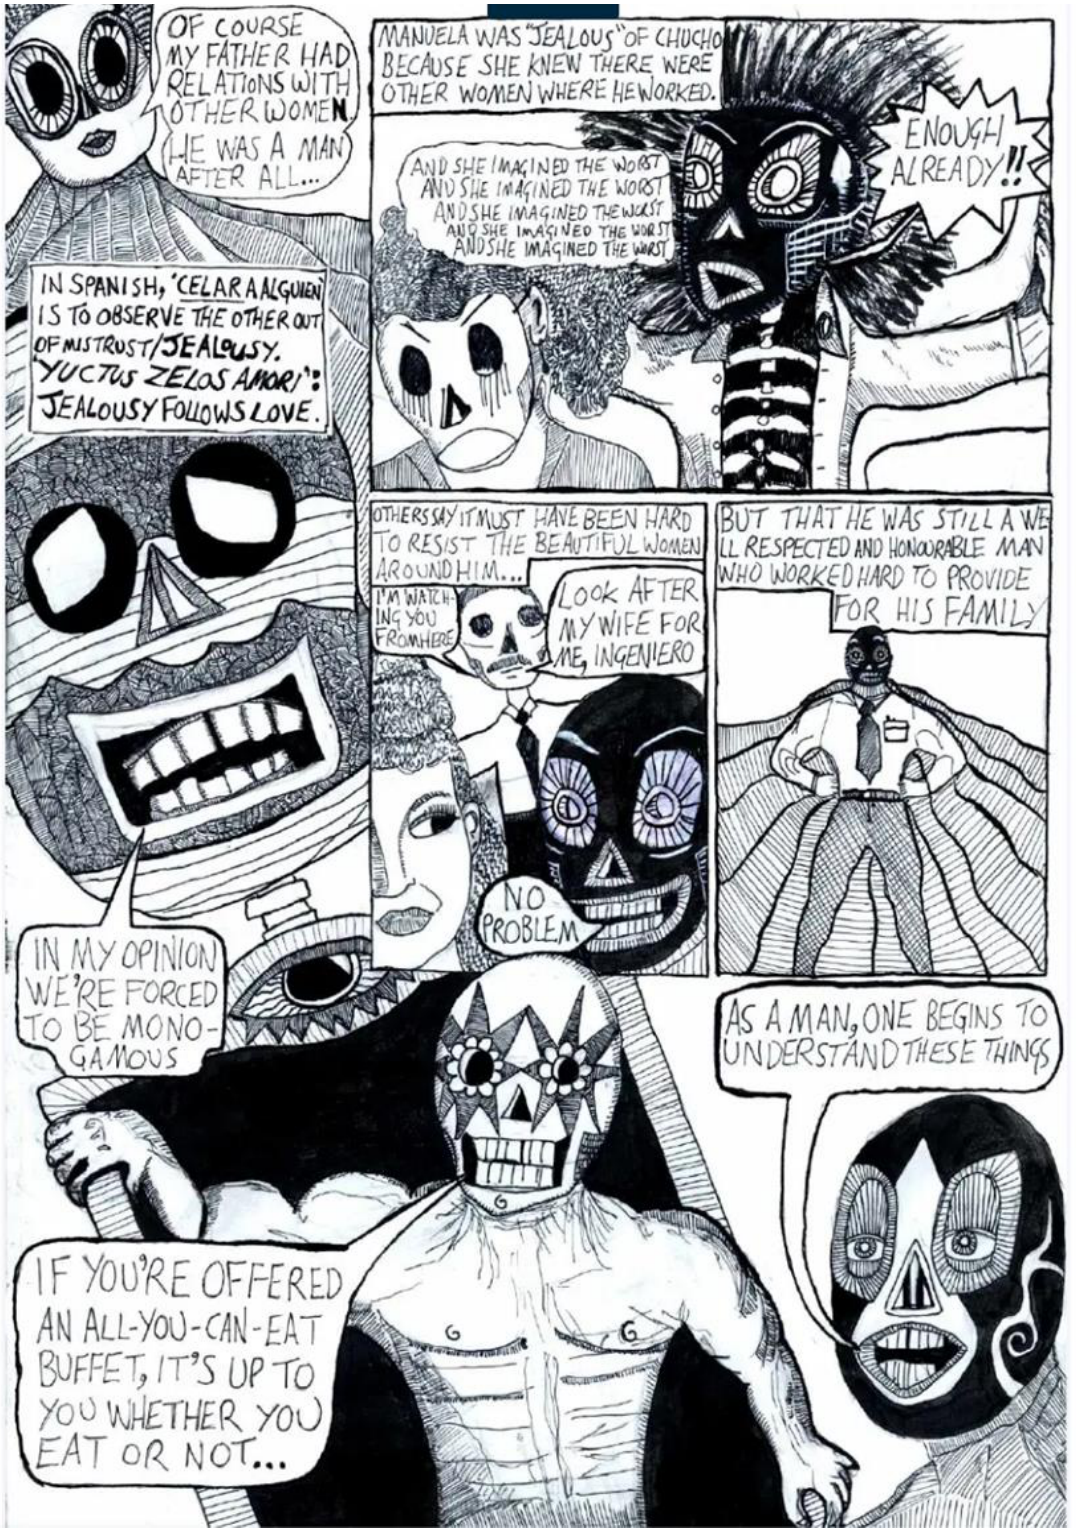
Figure 13: A page on monogamy, matrimony and masculinity (Sherwood Gonzalez 2019,